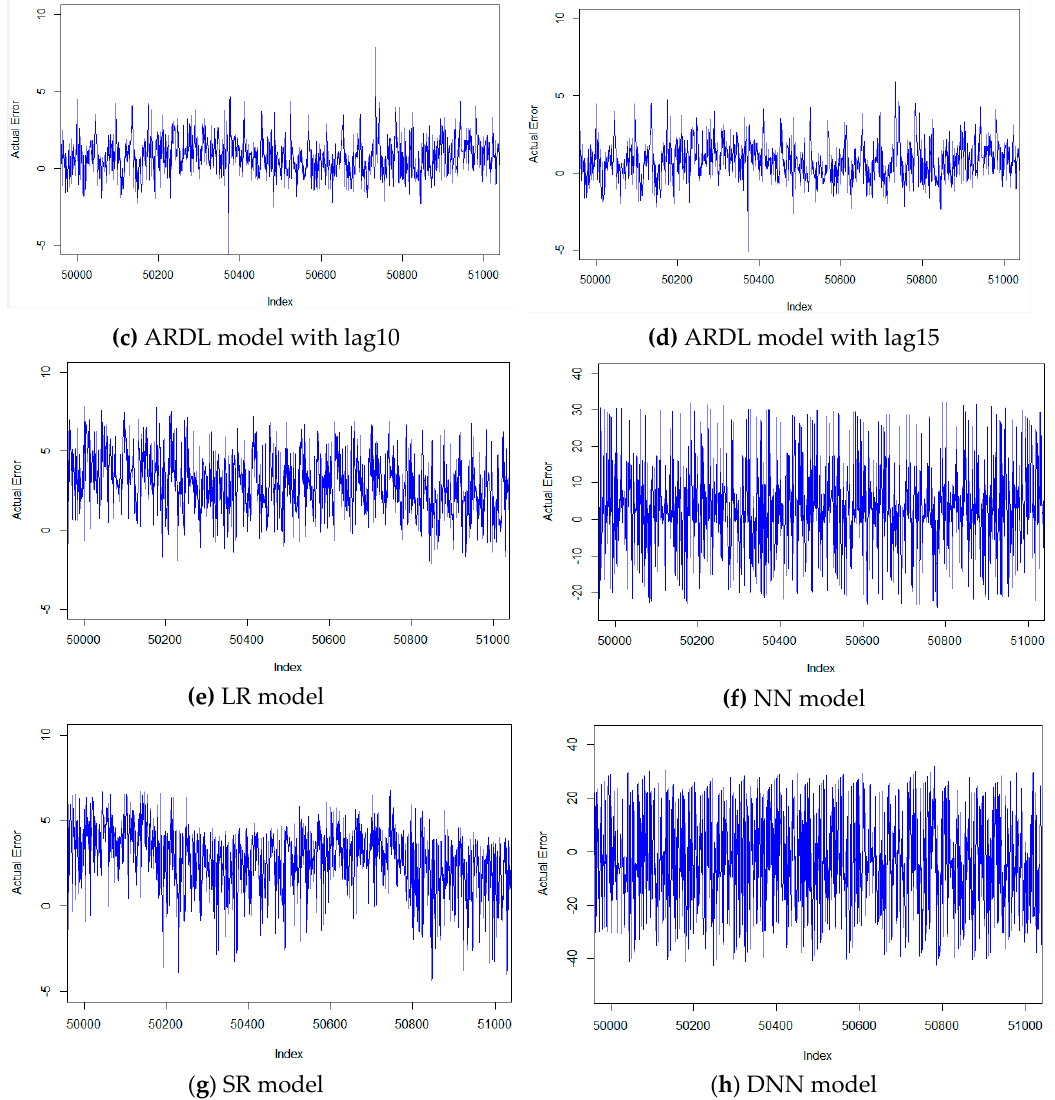
Figure 3. Actual error of all models for predicting the GTCOAT temperature. Figure 3 contains eight graphs, which were listed as follows: ( a ) ARDL model with lag 1, ( b ) ARDL model with lag 5, ( c ) ARDL model with lag 10, ( d ) ARDL model with lag 15, ( e ) LR model, ( f ) NN model, ( g ) SR model, ( h ) DNN model.